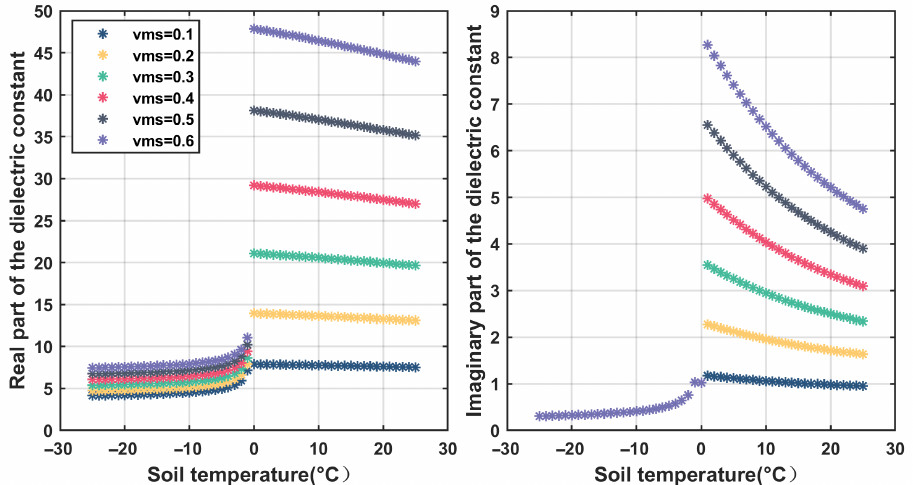
Figure 3. Variation of real and imaginary parts of the dielectric constant with soil temperature at different soil moisture contents.